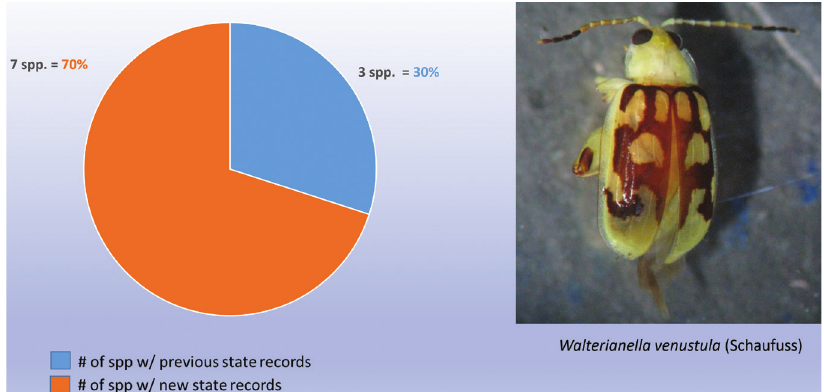
Figure 9. Walterianella Bechyné new state records versus previously recorded state